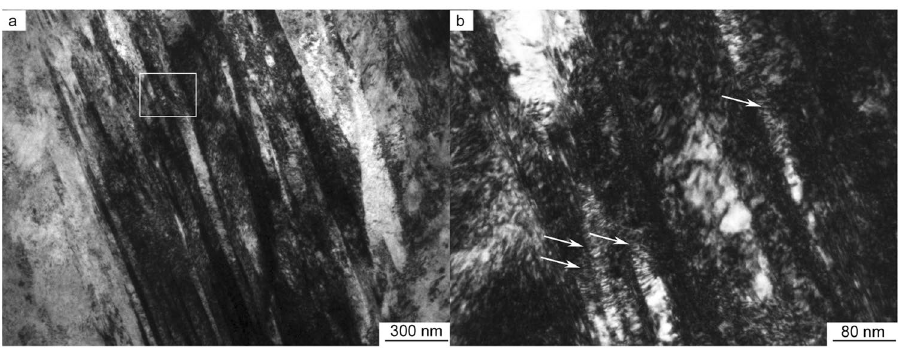
Figure 5. Microstructure after tensile test ( a ) TEM image of the tensile sample near the fracture zone showing high density of dislocations and ( b ) magnified zone of the white rectangle in ( a ), showing the numerous dislocation